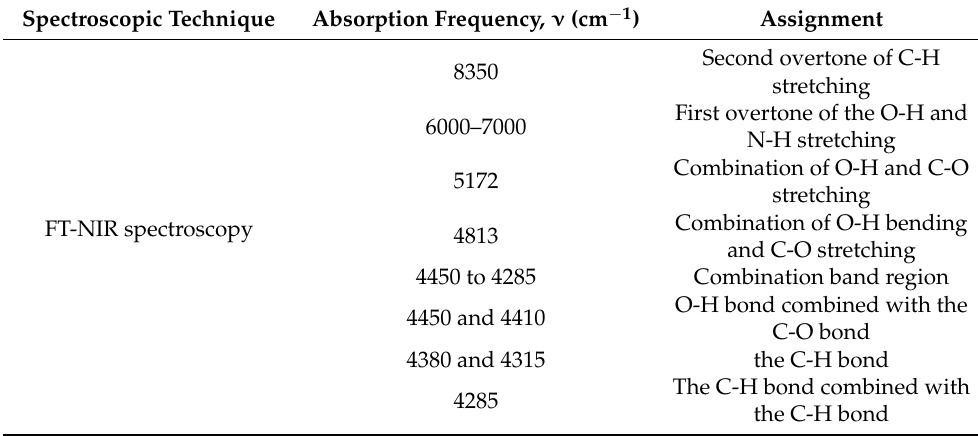
Table 2. FT-NIR spectral vibrations of phenolic compounds observed in A. thaliana leaf powder samples.